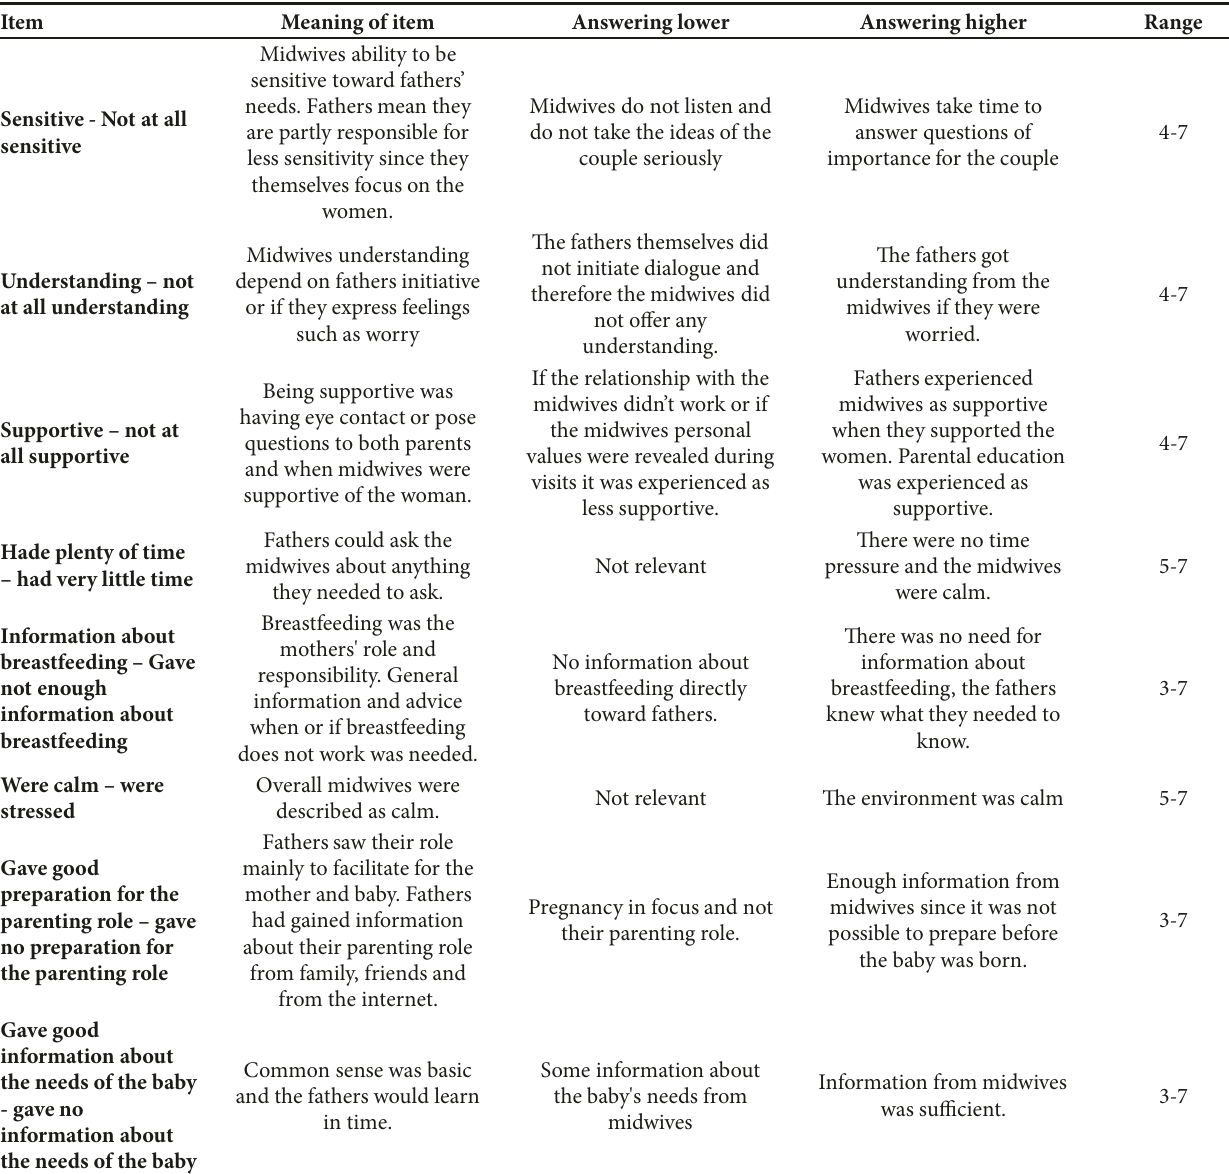
Table 1: Findings from fathers experience of professional support in relation to the FaPPS scale